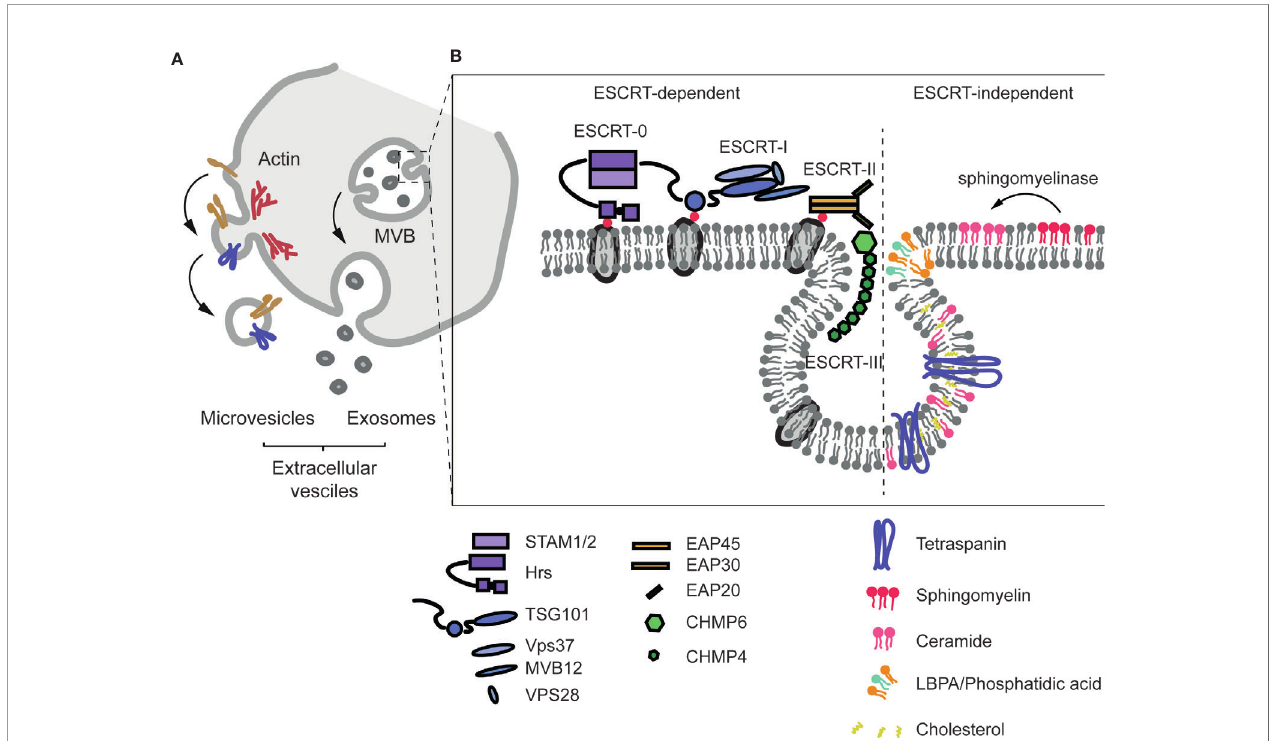
FIGURE 2 | Extracellular vesicle formation. (A) Extracellular vesicles are classi fi ed according to their origin. Microvesicles are formed from the PM in a process called ectocytosis that depends on the ESCRT machinery and the actin cytoskeleton. Exosomes are derived from the budding process on the membrane of the endosome/multivesicular body, and released to the extracellular space upon fusion of the endosome with the PM. (B) Diagram of the structure of the ESCRT machinery and of ESCRT-independent mechanisms implicated in exosome